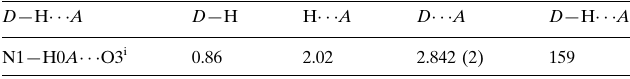
Hydrogen-bond geometry (A˚ , (cid:1)